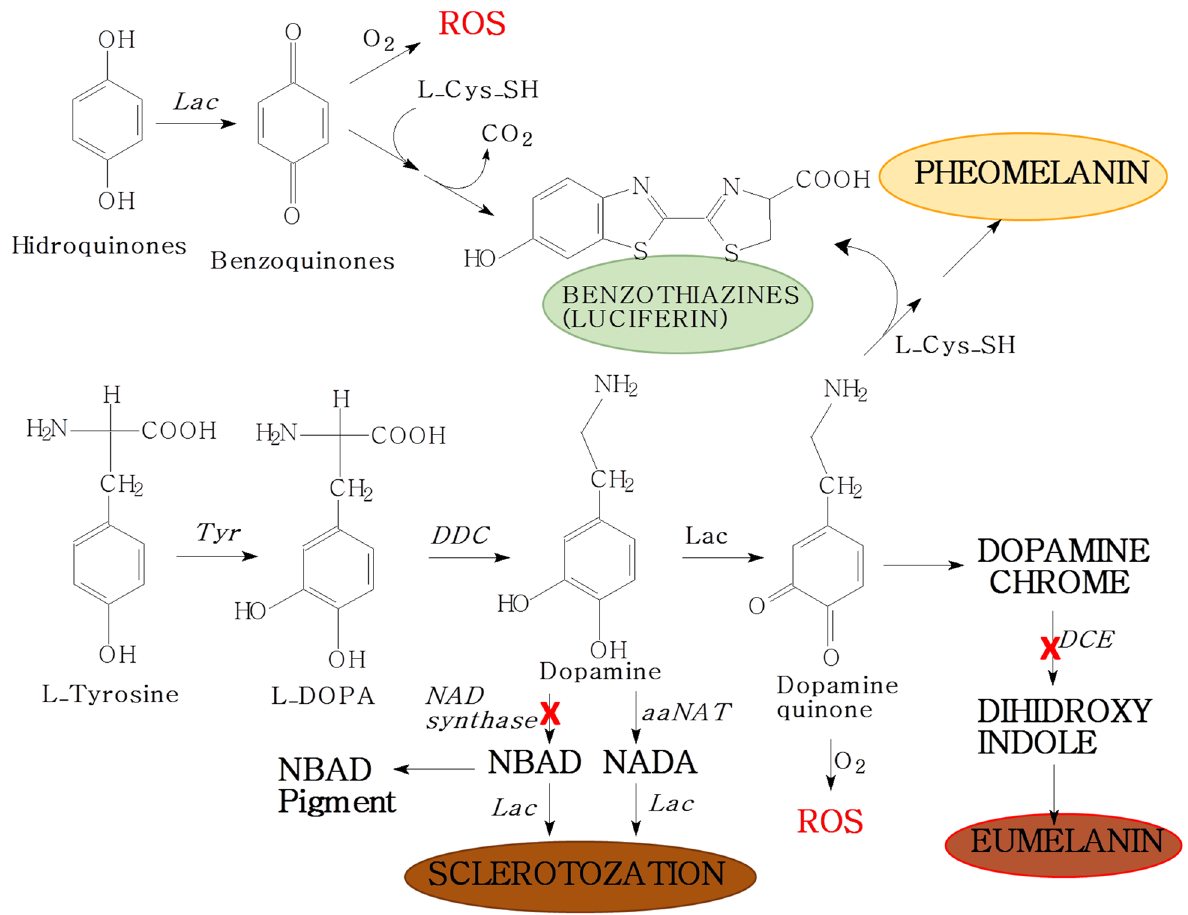
Figure 6. A proposed luciferin biosynthetic pathway as an alternative cysteine-dependent quinone detoxification route departing from the sclerotization and melanization pathways in beetles. The red crosses indicate enzyme deficient pathways that may lead to quinone accumulation and toxicity. Tyr Tyrosinases, Lac Lacases, DDC dopa decarboxylase, aaNAT dopamine N -acetil transferase, DCE dopachrome isomerase.